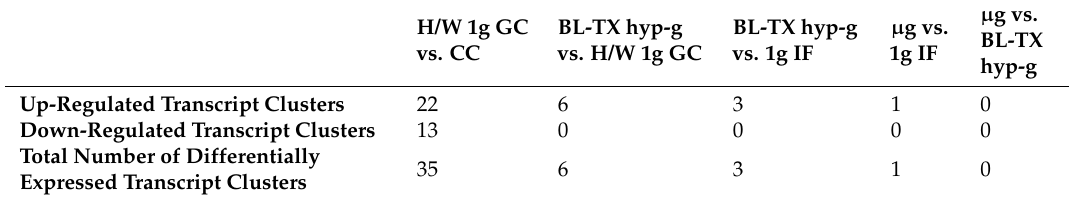
Table 10. Differentially expressed oxidative stress-related transcript clusters in Jurkat T cells during the TEXUS-51 mission. The number of significantly differentially expressed transcript clusters that were up-regulated or down-regulated in the respective comparison. Differential expression is defined as a t -test p -value < 0.05; fold change (FC) < − 1.3 or > +1.3. FCs are ratios between the averages of linear expression values. If the ratio is <1, FC is calculated as the negative reciprocal of the ratio. A total of 106 transcript clusters, belonging to 86 genes involved in oxidative stress response, were investigated. For the abbreviations of the experiment group names see Table